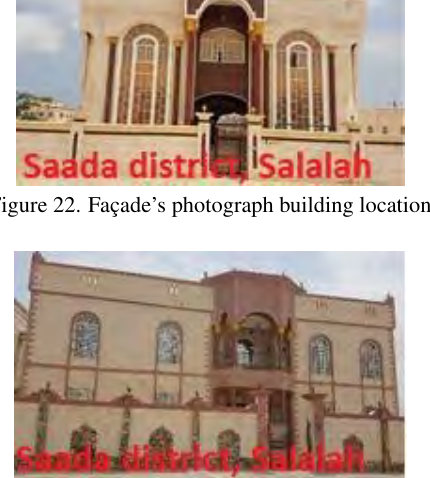
Figure 23. Fac¸ade’s photograph building location